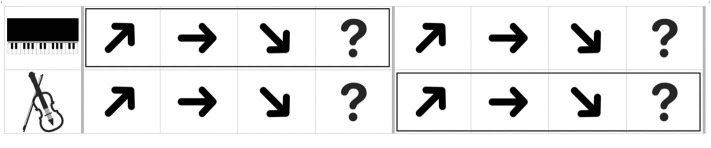
An example of an answer page given in a monitor with the musical stimuli (CIT3). The boxes were presented prior to presentation of each contour.